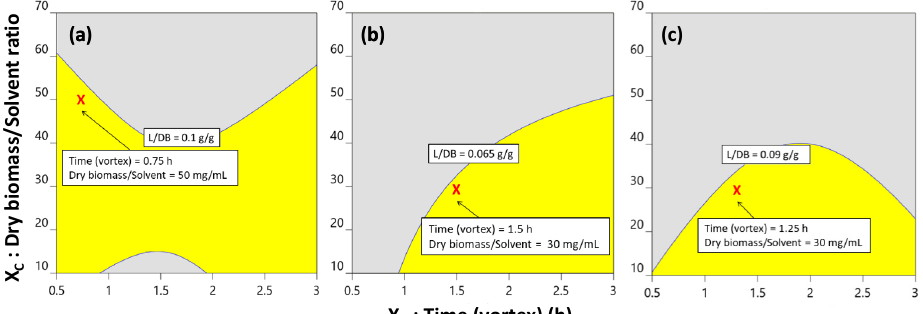
Figure 4. Overlay contour plots depicting the optimum desired space (yellow area) for all type of solvents, ( a ) MeOH/Hex; ( b ) Isop/Hex; and ( c ) MeOH/AcOEt concerning vortex time (X B ) and dry biomass/solvent ratio (X C ). The red Χ -mark shows the selected near optimal conditions for validation. Polar/non-polar ratio was equal to ( a ) 0.33, ( b ) 1.00, and ( c ) 0.60. investigation of the optimal areas obtained from the response surface and overlay plots (Figures 3 and 4). A decrease in vortex time was desirable to reduce the overall duration